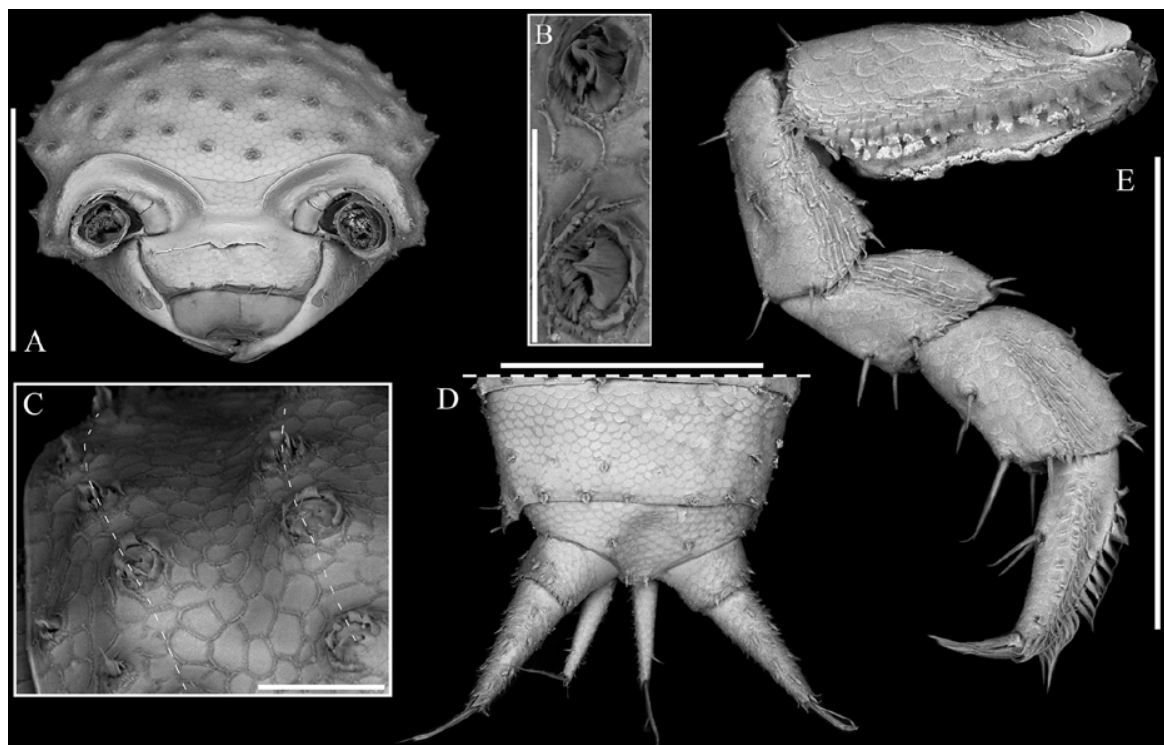
Figure 3. Pectenoniscus montalvaniensis n. sp. Male paratype: A , cephalon, frontal view; B , dorsal scaled setae; C , epimeron 2, dotted line indicating the lines of tubercles, dorsal view; D , pleonite 5, pleotelson and uropod, dorsal view; D , pereopod 7. Scale bars: A, D, E : 300µm; B: 40µm; C : 50µm.